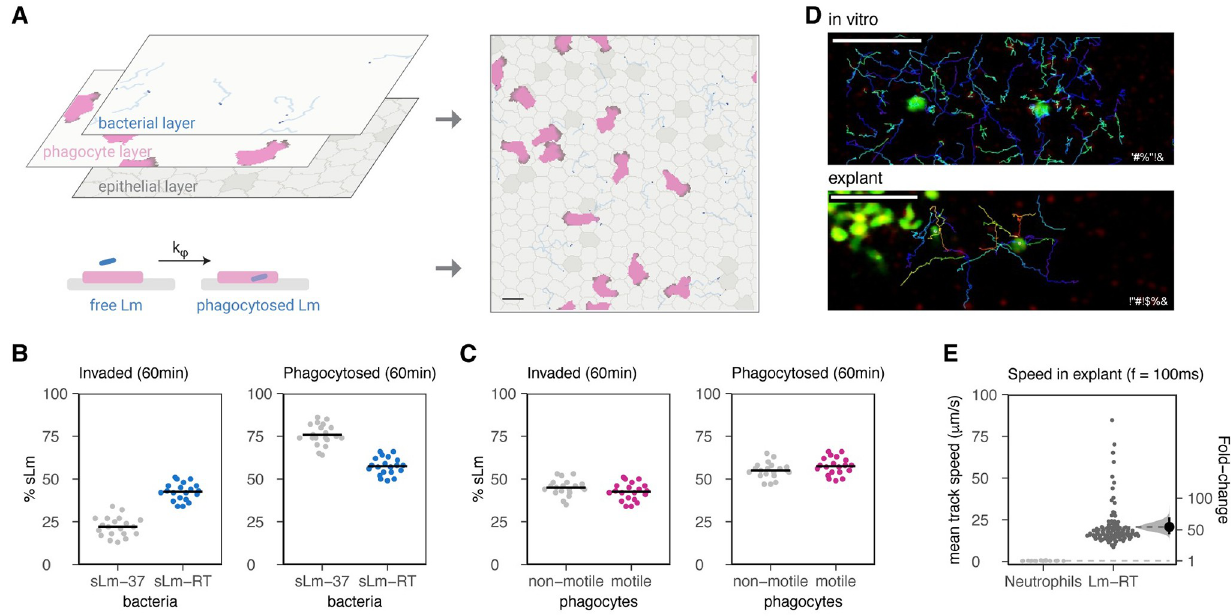
Fig 5. Bacterial motility, but not phagocyte motility, drives Lm-phagocyte interactions at the epithelium. A: To simulate bacterial phagocyte interactions on the epithelium, the model is extended by adding an extra layer containing migrating phagocytes (left). Phagocytes can phagocytose bacteria that move over them, or that have attached but not yet invaded a target cell. Phagocytosis is irreversible and occurs at rate k . These layers and dynamics are φ again combined to obtain the full model (right; scale bar = 10 μ m). See also Fig 4 and S1 Methods for details. B: % sLm invaded (left) and phagocytosed (right) after 60 min for both non-motile (sLm-37) and motile (sLm-RT) bacteria. C: the same as panel B, but now comparing motile (pink) versus non- motile (gray) phagocytes, while bacteria are all motile (sLm-RT). Non-motile phagocytes were modelled by setting the parameters λ act = 0, max act = 0 (see S1 Methods). For B,C, horizontal bars indicate the mean of 20 independent simulations. D: To confirm neutrophil-Lm-RT interaction dynamics, both cell types were imaged both in vitro (imaging both neutrophils and Lm-RT, see Methods) and in vivo (in an explanted ileum after rechallenge with BacLight- Red-labelled Lm-RT, see Methods). Images show LysM-GFP neutrophils in green, together with time-encoded tracks of Lm-RT over several seconds (frame rate: 100 ms). On this time scale, neutrophils are essentially static while many Lm-RT can be observed moving at high speeds, often colliding with neutrophils and moving past them. Scale bars represent 50 μ m. E: comparison of mean track speeds of Lm-RT and neutrophils as determined in the in vivo system from panel D (frame rate: 100ms) Lm-RT move at least * 55 times faster than neutrophils (95% CI [43–70]). Bootstrapped fold-changes (Lm-RT w.r.t. neutrophils) are displayed as in Fig 2H and 2I.